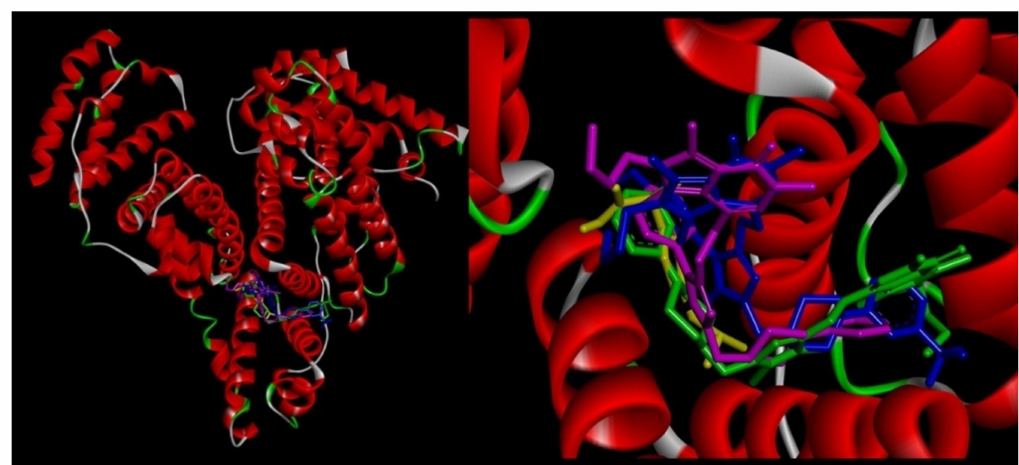
Figure 12. Docking poses of 4a (pink), 4b (green), 5c (blue) and Ibuprofen (yellow) inside BSA site II (m).